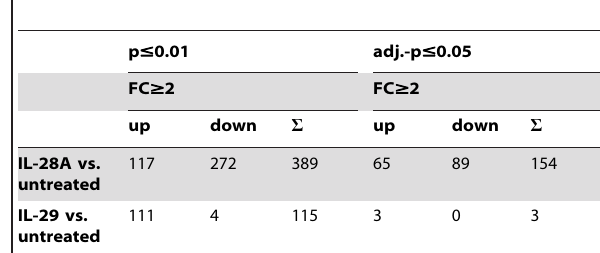
Figure 2. IL-28A and IL-29 strongly activate STAT1 but not STAT3 in naı¨ve Huh-7 cells. Activation and expression of phospho- STATs and protein loading of the respective STAT proteins were assessed by immunoblotting. (A) Phospho-STAT1 activation after 15 min of stimulation with IL-28A and IL-29 (100 ng/ml). (B) STAT3 is phosphorylated only to a low extent by stimulation with IL-29 but not with IL-28A. One representative experiment (n=3) is shown.